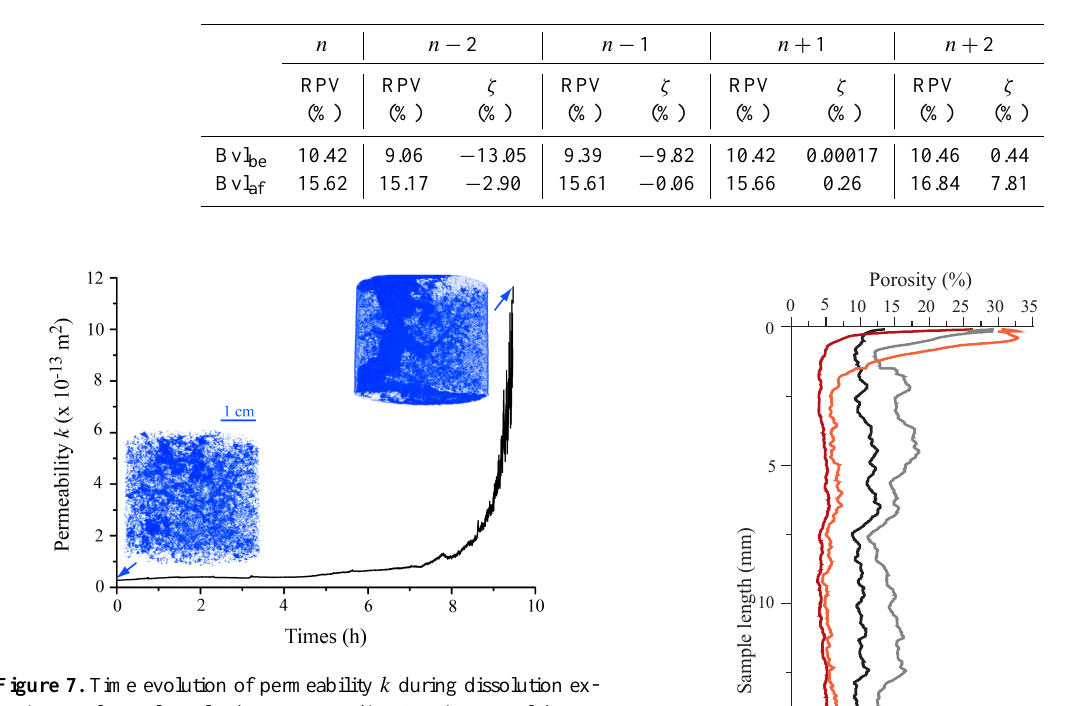
Table 3. Sensitivity analysis of the threshold value n value on the relative fraction of the resolved phase volume (RPV [%]) for samples Bvl be and Bvl af with the relative error ζ [%].